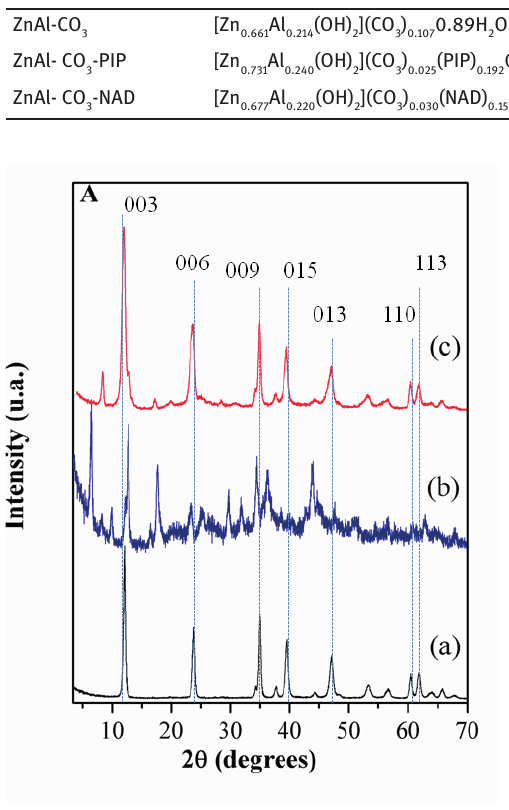
: (a) free of organic 3